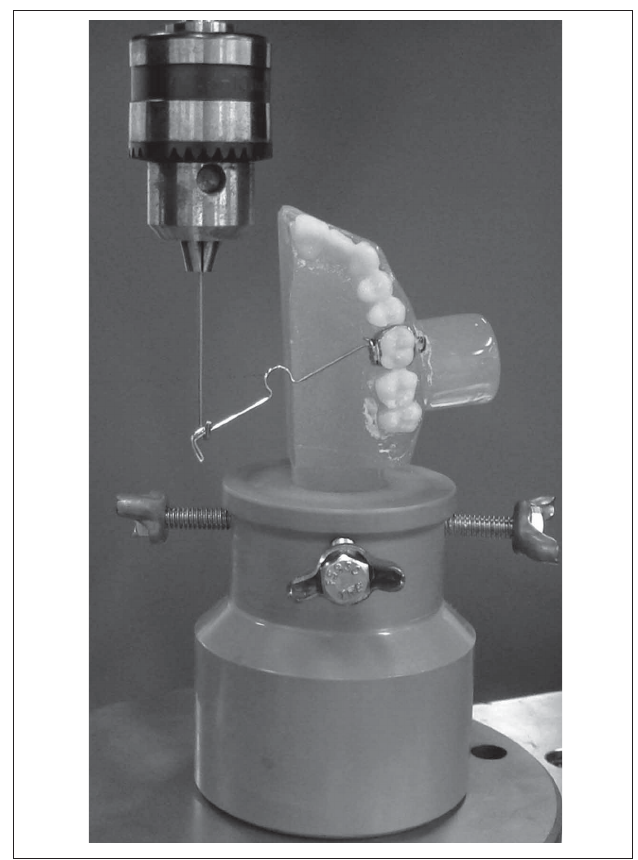
Fig. 2. Device used to attach the bars during the mechanical tests.